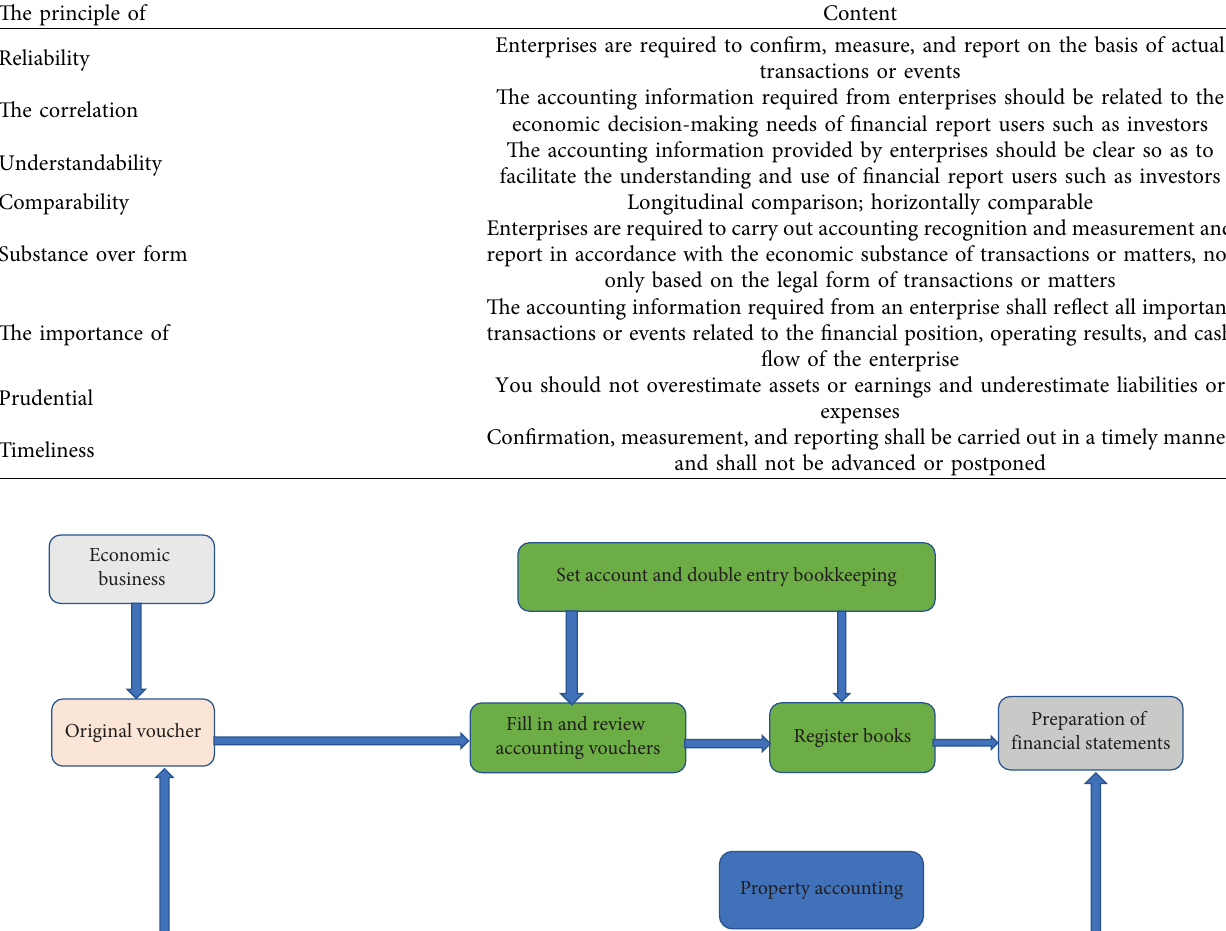
Table 2: Eight basic principles of accounting.